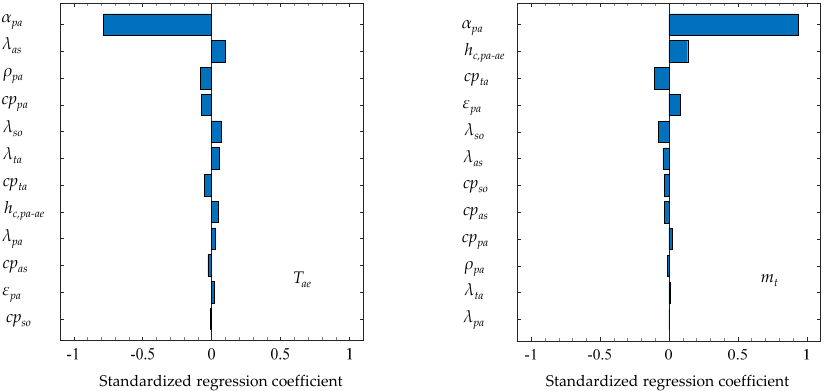
Figure 7. Standardized regression coefficient R from the sensitivity analysis of exit temperature ( T ae ) and instantaneous mass ( m t ) of the thermal sun drying model on 4 June 2012 (paddy rice: α pa —albedo, d pa —density, cp pa —volumetric heat capacity, λ pa —thermal conductivity; PVC tarpaulin: cp ta — volumetric heat capacity, λ pvc —thermal conductivity; Asphalt: cp as —volumetric heat capacity, λ as — thermal conductivity; Soil: cp so —volumetric heat capacity, λ so —thermal conductivity, h c heat transfer coefficient from the paddy rice to the air).